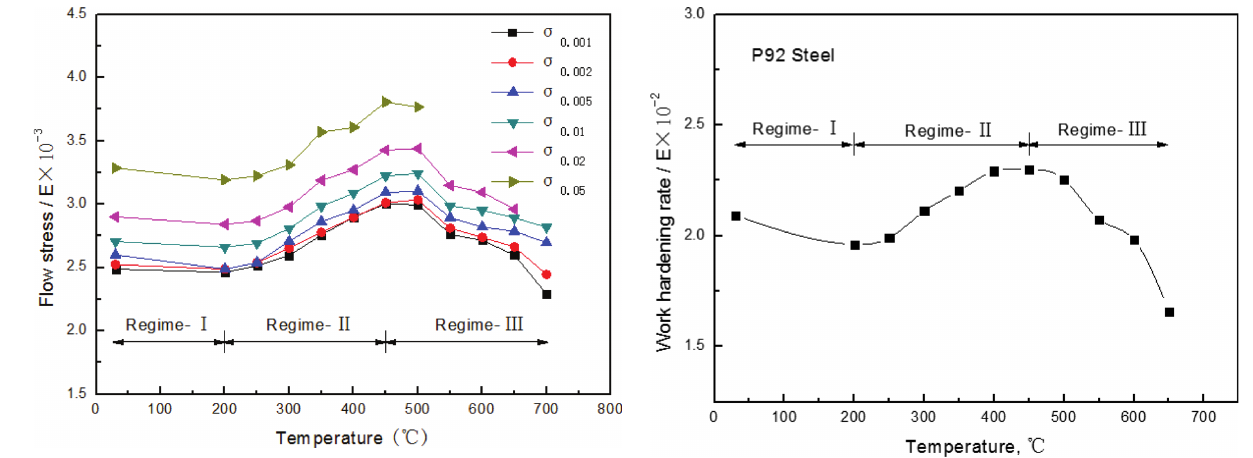
Figure 4: Variations of normalized flow stress at different true plastic strain with temperature at strain rate of 5 × 10 − 5 s − 1 .